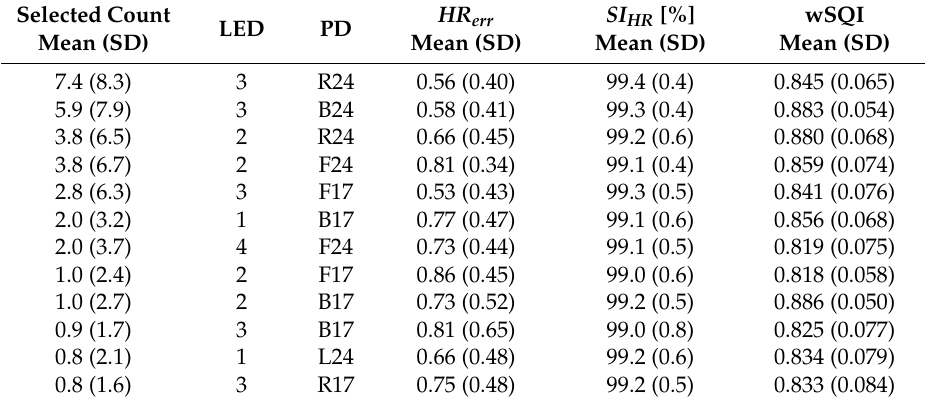
Table 4. HR err , SI HR and wSQI for all participants from the top 12 LED-PD pairs with a gap between the skin and